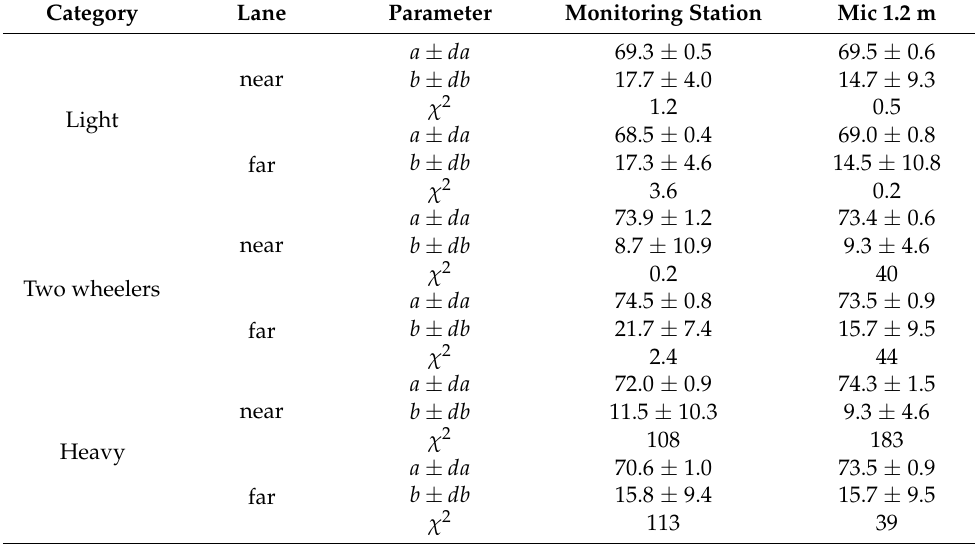
Table 8. SEL fit comparison for night U-SPB and SPB-L in V. a and b units are dB(A).